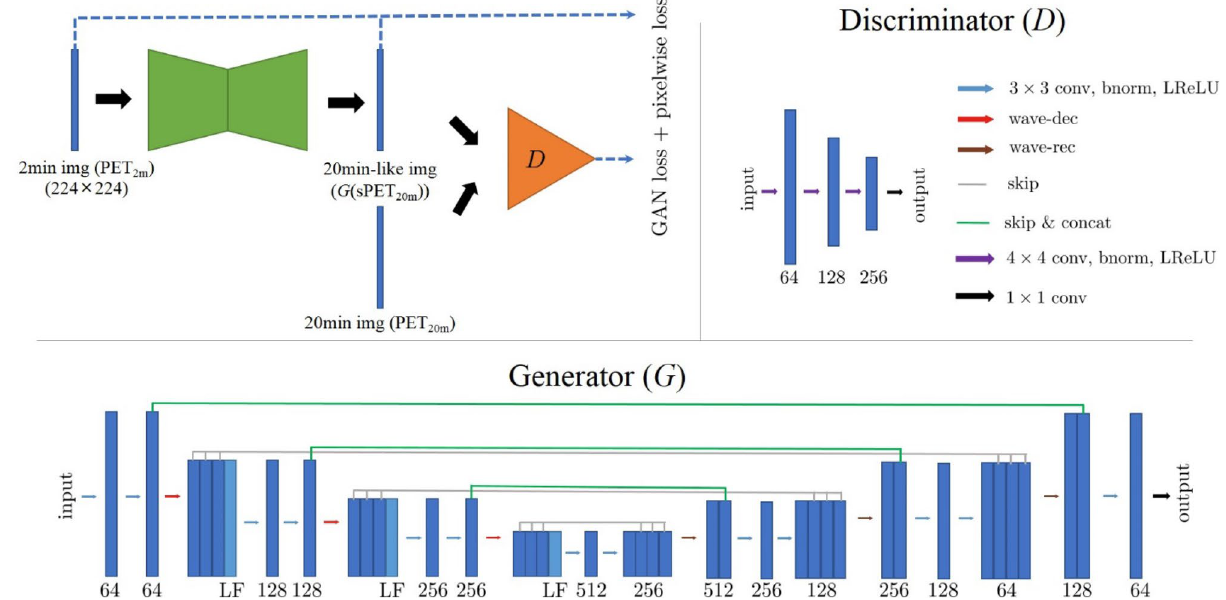
Figure 1. The schematic diagram of the adversarial network used in this study (top left). In this proposed network, the discriminator (top right) and the generator (bottom row) are shown, and the generator is constructed using the deep convolutional framelets. The numbers below the rectangular boxes indicate the number of The generator is constructed using the deep convolutional framelets, which consist of encoder-decoder struc- tures with skipped connections 16 . Both encoder and decoder paths contain two repeated 3 × 3 convolutions (conv), each followed by a batch normalization (bnorm) and a leaky rectified linear unit (LReLU) 17,18 . A 2-D Haar wavelet de-composition (wave-dec) and re-composition (wave-rec) are used for down-sampling and up-sampling, respectively, of the features 19 . In the encoder path, three high-pass filters after wavelet de-composition skip directly to the decoder path (arrow marked by ‘skip’), and one low-pass filter (marked by ‘LF’) is concatenated with the features in the encoder path at the same step (arrow marked by ‘skip & concat’). At the end, a convolu- tion layer with a 1 × 1 window is added to match the dimension of input and output images. The numbers below the rectangular boxes in Fig. 1 indicate the number of filters. The architecture of deep convolutional framelets is similar to that of the U-net 20 , a standard multi-scale convolutional neural network (CNN) with skipped con- nections. The difference is in using the wavelet de-composition and re-composition, instead of max-pooling and un-pooling, for down-sampling and up-sampling, respectively. Additional skip connections of high-frequency filters help to train the detailed relationship between PET 2m and PET 20m images. For the discriminator, we adopted the standard CNN without a fully connected layer. The discriminator contains three convolution layers with a 4 × 4 window and strides of two in each direction of the domain, each followed by a batch normalization and a leaky ReLU with a slope of 0.2. At the end of the architecture, a 1 × 1 convolution is added to generate a single-channel image.